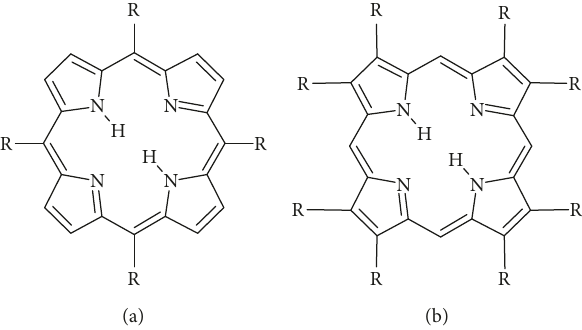
Figure 12: Structures of the (a) mesosubstituted and (b) β -substituted porphyrins.